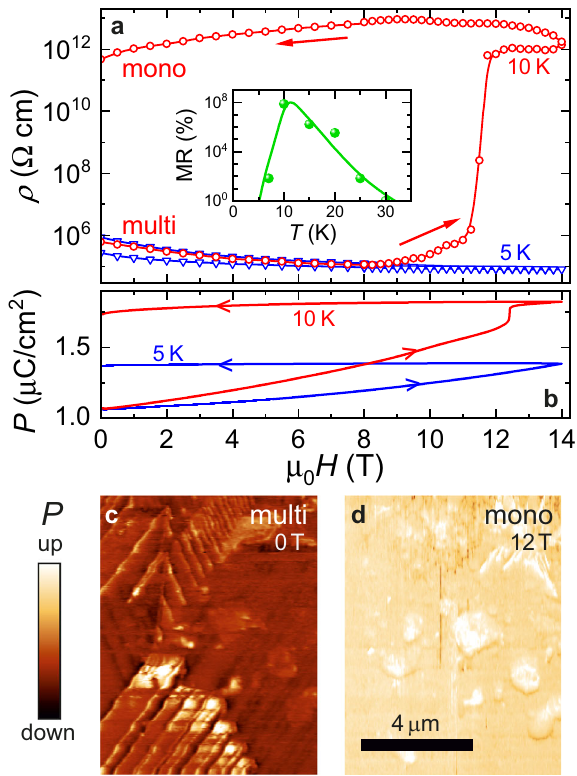
Fig. 5 In situ magnetic erasure of conductive DWs. a MR of a bulk multi- domain crystal at 5 and 10 K, after poling with E p = − 5.5 kV/cm. Irreversible magnetic switching from a low- to the high-resistance state was observed at 10 K. The inset shows the difference of the zero- fi eld resistance before and after the switching. b Field-dependent polarization of a multi- domain crystal at 5 and 10 K, after poling with E p = − 5.5 kV/cm. At 10 K it shows a jump at ~12 T, close to the fi eld value where a jump in resistivity is observed. c , d PFM images recorded on the (111) surface of an unpoled crystal at 15 K in a 0 T multi-domain and the 12 T mono-domain state,